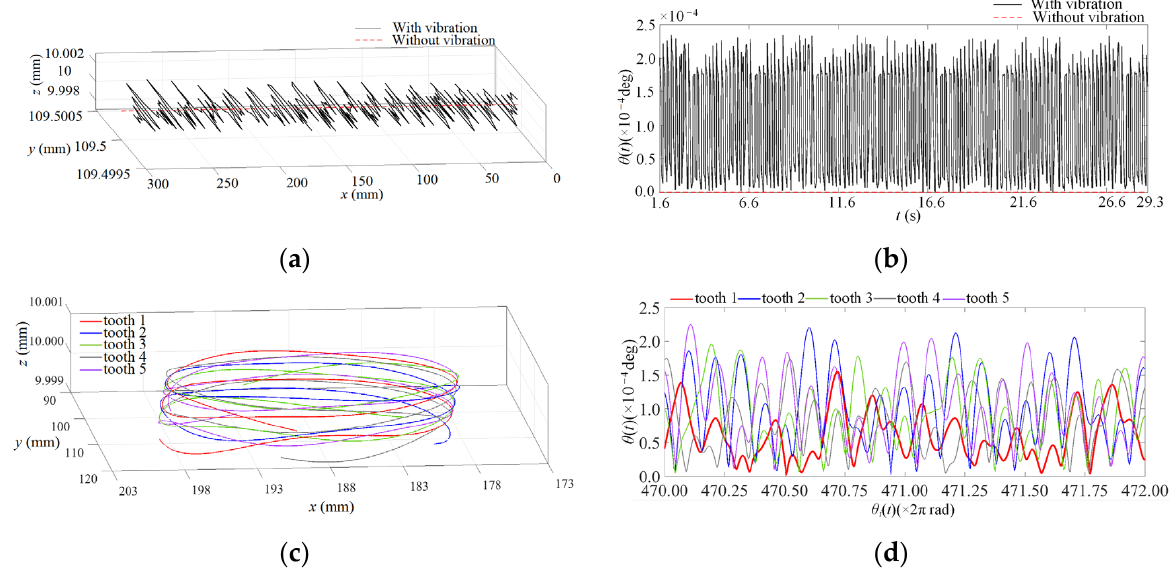
Figure 7. Trajectory and attitude angle of milling cutter and cutter tip. ( a ) Milling cutter trajectory; ( b ) milling cutter attitude angle; ( c ) cutter tip trajectory; ( d ) cutter tip attitude angle.